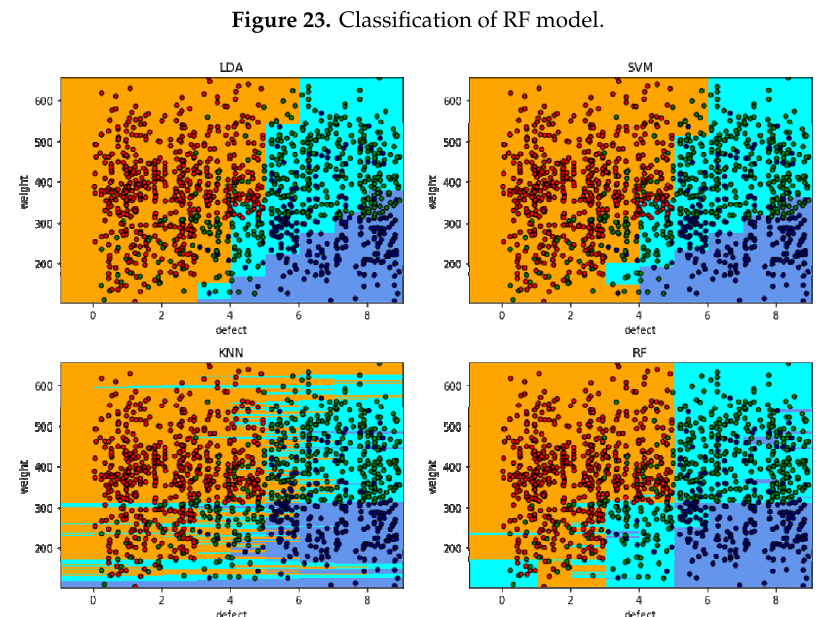
Table 5. The accuracy of model.